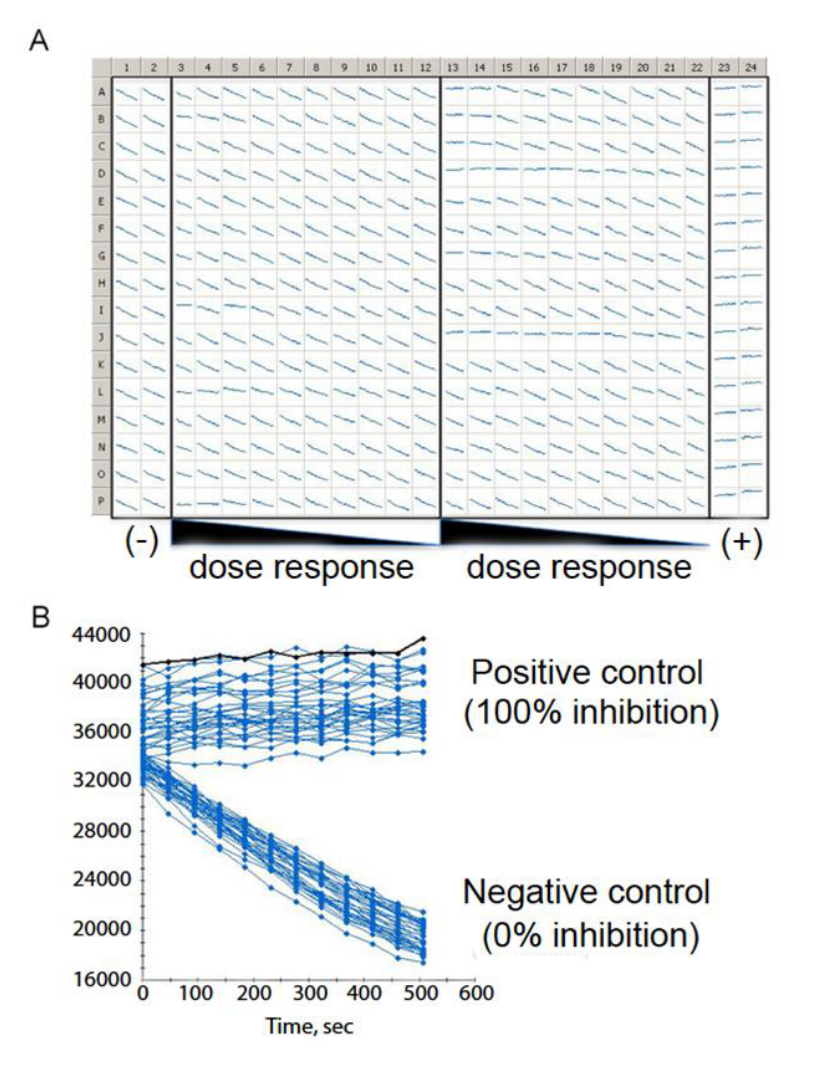
FIGURE 12: FRET-based endonuclease assay. (A) A representative 384-well plate view kinetic measurement of the FRET-based MUS81-EME1 assay, with compounds tested in 10- concentrations dose response. (B) Graph shows the slope / reaction rate for assay controls. Kinetic readout (Excitation 535 nm / Emission 665 nm) for 8 minutes at linear phase was measured per assay plate and data was calculated as slope from a time series of 12 data points representing the rate of reaction. The assay was robust with Z’ performance of 0.74 ±